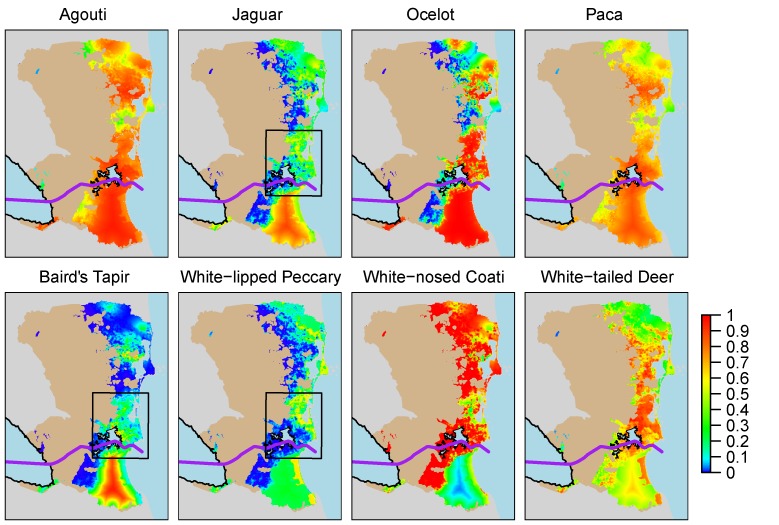
Occupancy maps for all species (model CA1).Black rectangle indicates extent of close up map (Fig 3), light brown area indicates agricultural land cover used as a mask.